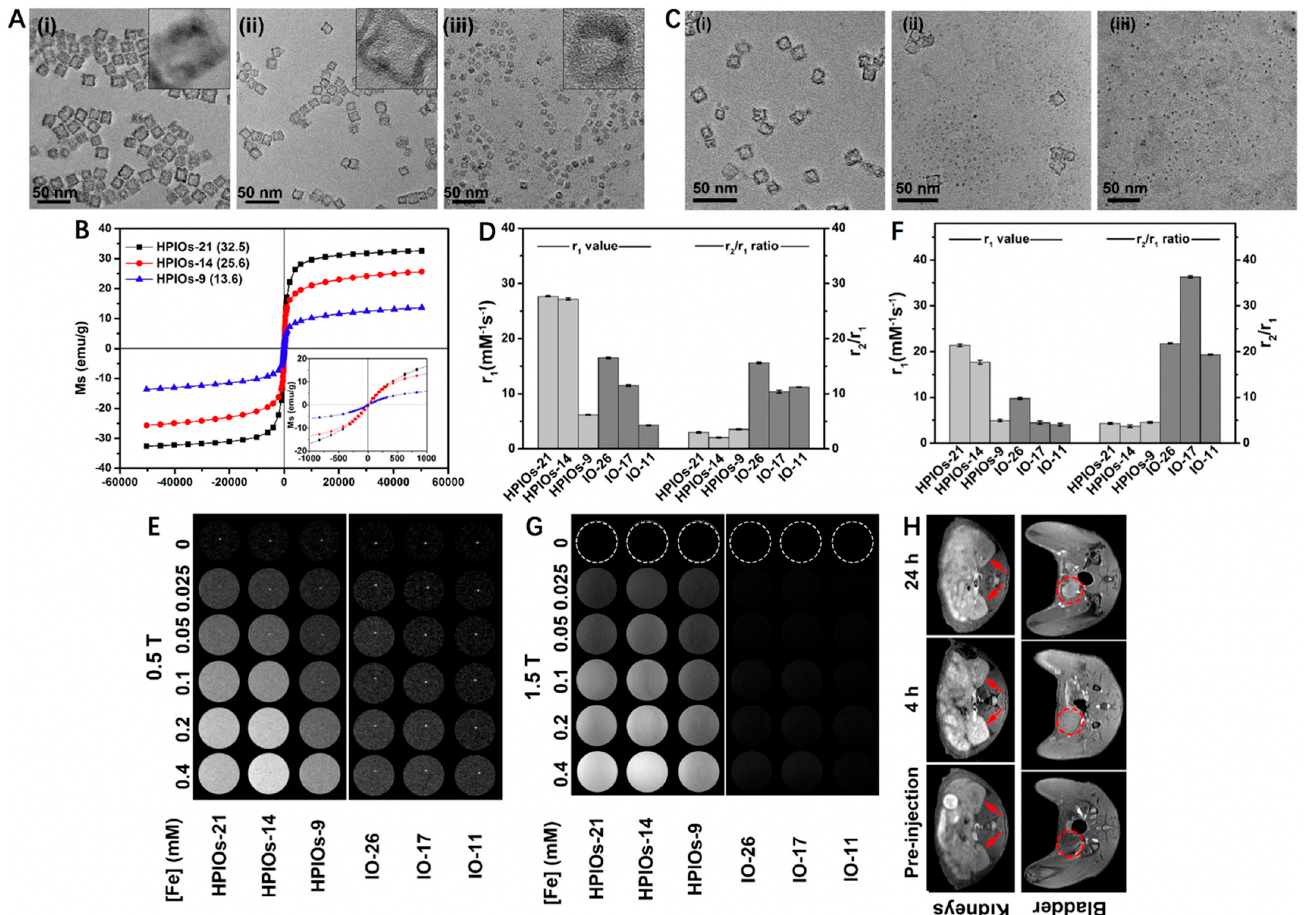
Figure 1. ( A ) Transmission electron microscopy (TEM) images and high-resolution TEM (HRTEM) images (inset) of HPIOs-21 ( i ), HPIOs-14 ( ii ), and HPIOs-9 ( iii ). ( B ) Field-dependent magnetization curves (M − H) of HPIOs-21, HPIOs-14, HPIOs-9 at a magnetic field of 5 T at 300 K (insets: magnification of M − H curves from − 1000 to 1000 Oe). ( C ) TEM images of HPIOs-14@ZDS incubated in PBS (pH 7.4) buffer for 1 ( i ), 2 ( ii ), and 4 ( iii ) h, respectively. Relaxation measurements of HPIOs and IOs at ( D ) 0.5 and ( F ) 1.5 T. T 1 -weighted phantom imaging of HPIOs-21, HPIOs-14, HPIOs-9, IO-26, IO-17, and IO-11 on ( E ) 0.5 T and ( G ) 1.5 T MRI scanners. ( H ) In vivo T 1 MR imaging in the axial plane of rats before and at 4 and 24 h after injection of HPIOs-14 at a dose of 0.05 mmol Fe/kg body weight. Arrows and dotted circles indicate the kidneys and bladder, respectively. Reprinted with permission from Ref. [58]. Copyright 2018, American Chemical Society.